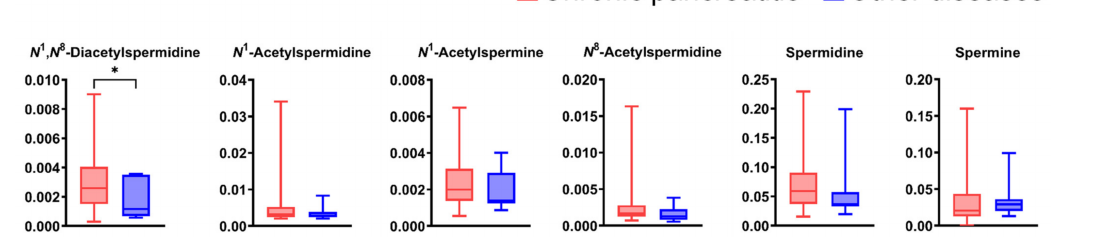
Figure A2. Differences in salivary polyamine concentrations between patients with chronic pancre- atitis ( n = 60) and those with other pancreatic diseases ( n = 7). Horizontal lines of box plots present 0, 25, 50, 75, and 100% of data. * p < 0.05, analyzed using the Mann–Whitney U test.